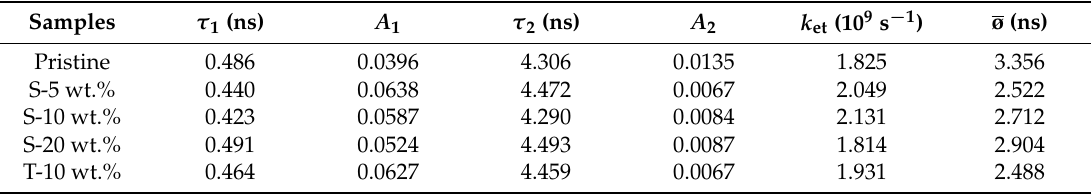
Figure S1: Grain size distribution of perovskite films on m-TiO 2 layer/(a)–(f): 0, 5 wt.%, 6.7 wt.%, 10 wt.%, 20 wt.% and 33.3 wt.% of Ag NPs in c-TiO 2 layer/S-FTO, and (g) Grain size distribution of perovskite films on m-TiO 2 layer/c-TiO 2 layer with 10 wt.% Ag NPs/T-FTO. Figure S2: XRD patters of the perovskite layers on FTO/TiO 2 with various Ag NPs concentrations of 0, 5 wt.%, 6.7 wt.%, 10 wt.%, 20 wt.%, 33.3 wt.%. Figure S3: Surface morphologies of AFM images of (a) c-TiO 2 /S-FTO and (b) c-TiO 2 after embedding 10 wt.% Ag NPs/S-FTO (c) c-TiO 2 after embedding 10 wt.% Ag NPs /T-FTO. Figure S4: The device performance under forward scan and reverse scan of (a) pristine sample and (b) T- 10 wt.% sample. Figure S5: The stability test of PSCs without or with Ag NPs concentration from 5 wt.% to 20 wt.% without encapsulation conditions. Table S1: The average photovoltaic performances summary of the perovskite devices.